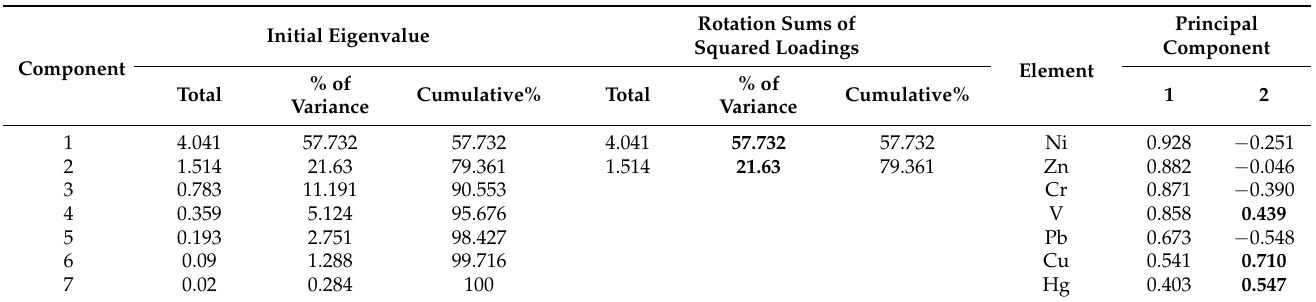
Table 10. Initial eigenvalue, rotation sums of squared loadings, and the principal component of each